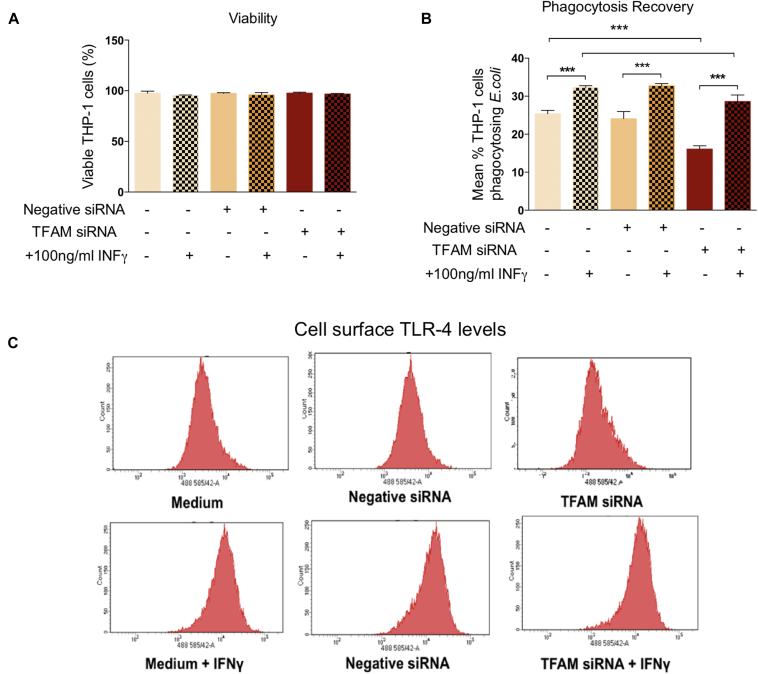
Treatment with IFN-γ increases TLR-4 expression and restores immune functions in THP-1 cells with mtDNA depletion following transfection with TFAM siRNA. THP-1 cells were treated with 100 ng/mL recombinant human IFN-γ or medium for the final 24 hours of an 8-day transfection with negative control or TFAM siRNA, or incubation with growth medium. A, Cell viability. B, Phagocytosis of E coli. C, Cell surface expression of TLR-4. All experiments were carried out on 3 independent biological replicates and are presented as means ± SD. ***P < .001.